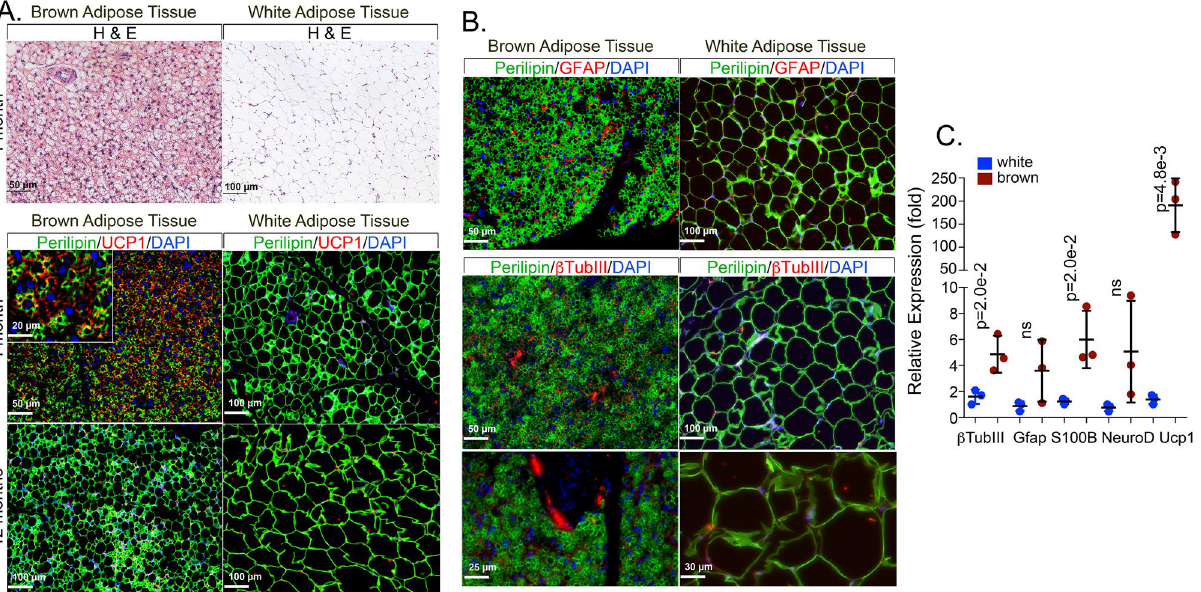
Figure 1. Enhanced expression of neurogenic markers in mouse brown adipose tissue. ( A ) H&E staining of mouse BAT (interscapular) and WAT (inguinal) (top). Expression of perilipin (green) and uncoupling protein 1 (UCP1, red) in brown and white adipose tissue from mice aged one month and 12 months as detected by immunofluorescence. ( B ) Expression of perilipin (green) and the neurogenic markers glial fibrillary acidic protein (GFAP, red) and β tubulin III (βTubIII, red) in brown and white adipose tissue from mice aged one month, as detected by immunofluorescence. ( C ) Expression of βTubIII, GFAP, S100 Calcium Binding